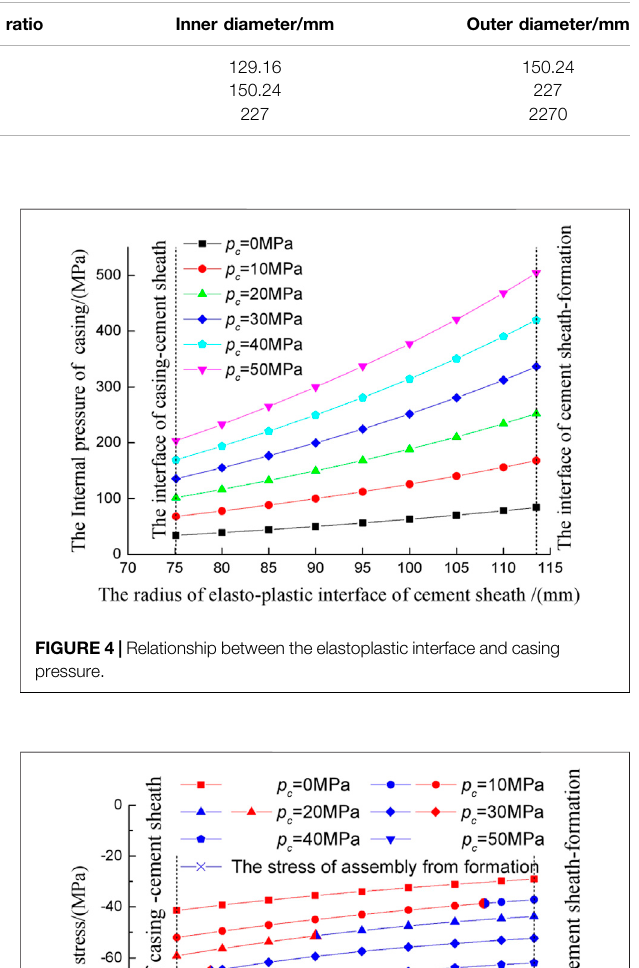
TABLE 1 | Physical and mechanical parameters of the casing – cement sheath- formation model.